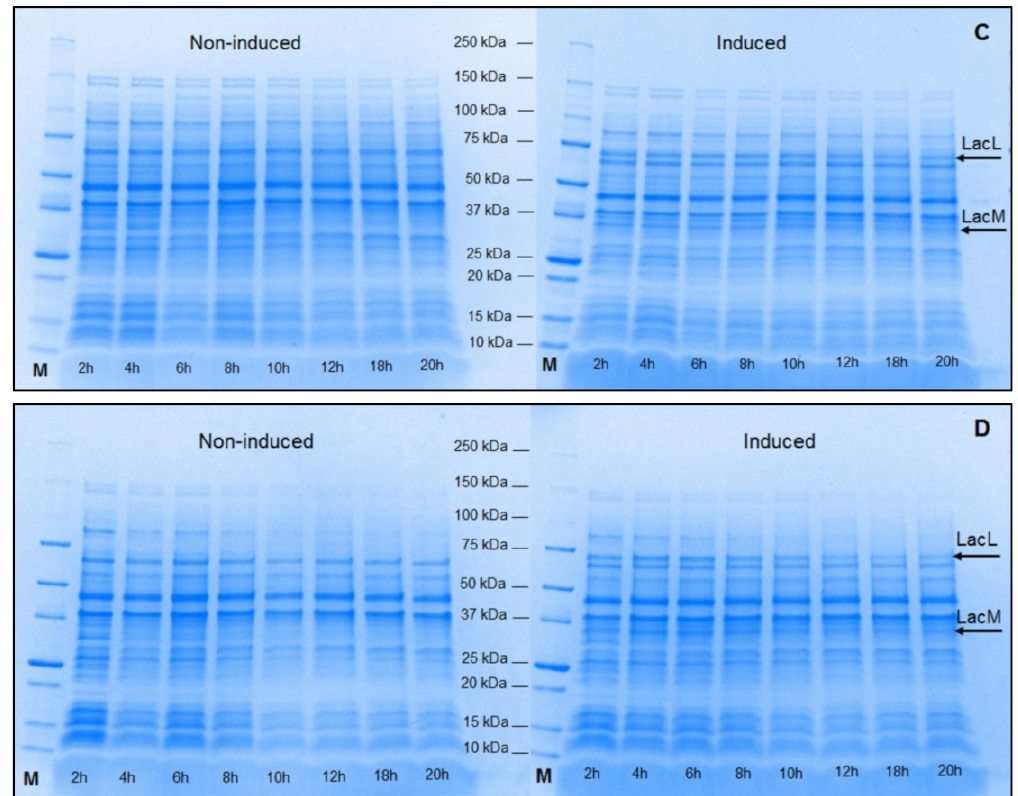
Figure 1. SDS-PAGE analysis of cell-free extract of crude Escherichia coli BL21 Star (DE3) ( A ), E. coli T7 Express containing the plasmid pGRO7 ( B ), Lactobacillus plantarum WCFS1 ( C ) and L. plantarum TLG02 ( D ) overexpressing β -galactosidase from Lactobacillus helveticus DSM 20075. E. coli BL21 Star (DE3) and T7 Express GRO carrying the plasmid pET21lacLMLh were cultivated in 300 mL LB medium; whereas L. plantarum WCFS1 and L. plantarum TLG02 harboring the plasmids p409lacLMLh and p609lacLMLh, respectively, were cultivated in 500 mL MRS at 30 ◦ C. The cultivation and induction conditions are as described in Materials and Methods and samples were taken at different time points during cultivations (non-induced cultures) and after induction during cultivations (induced cultures). The arrows indicate the LacL and LacM subunits of the recombinant β -galactosidase. M denotes the Precision protein ladder (Biorad, CA,